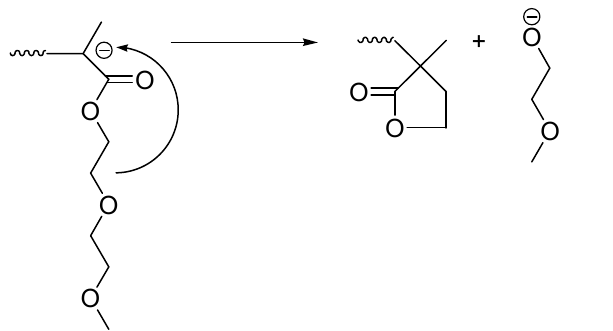
Figure 9. Potential termination of chain propagation by reaction of the living chain end with its own side-chain with the formation of 5-member ring.